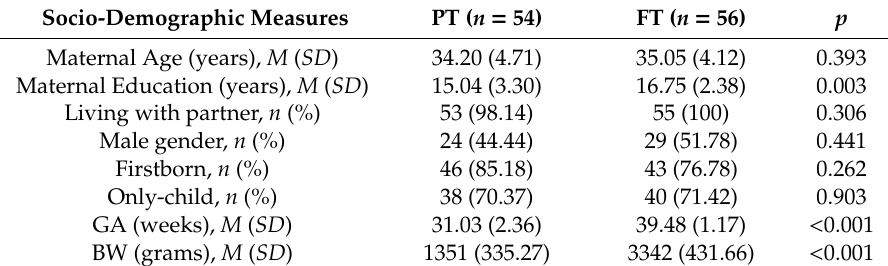
Table 1. Descriptive data and comparisons between